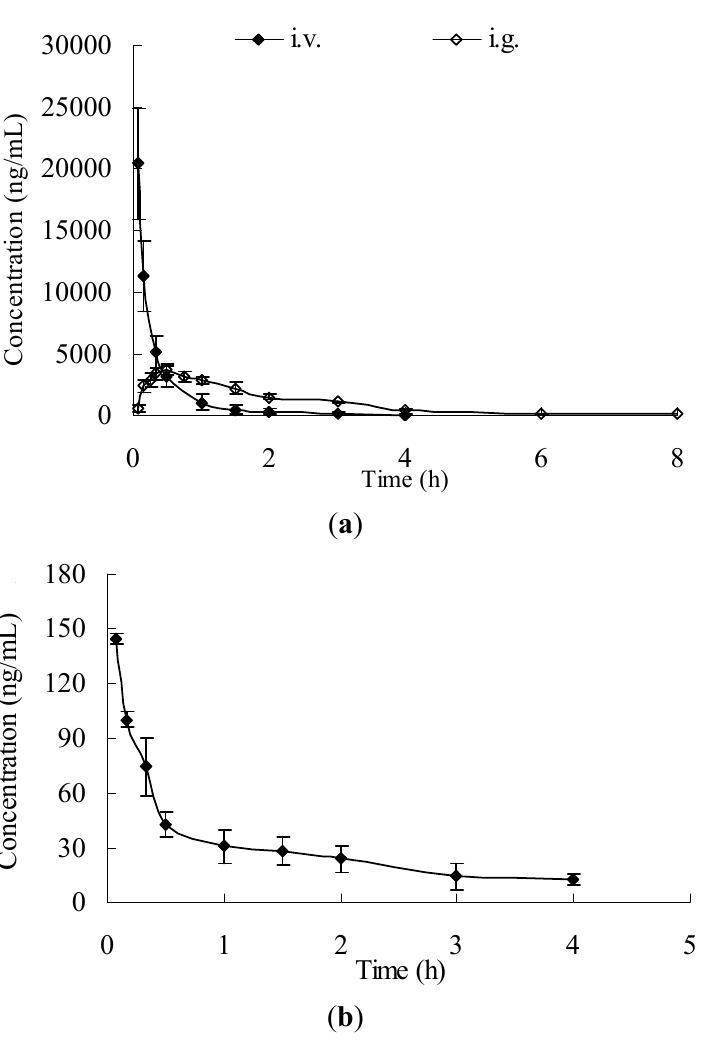
Figure 5. Mean concentration-time profiles in rat plasma (n = 6) obtained after i.v. administration of salidroside (i.v. 50 mg/kg) and i.g. administration of salidroside (i.g. 100 mg/kg). ( a : salidroside; b : p- tyrosol).